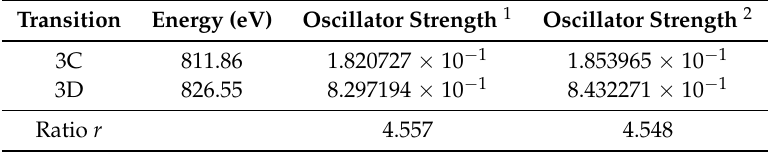
Table 6. Values of the oscillator strengths of 3C and 3D lines calculated with our MCDF code [90,91] in the “transition state” approximation. The value of the ratio r is not very sentitive to the choice of the gauge